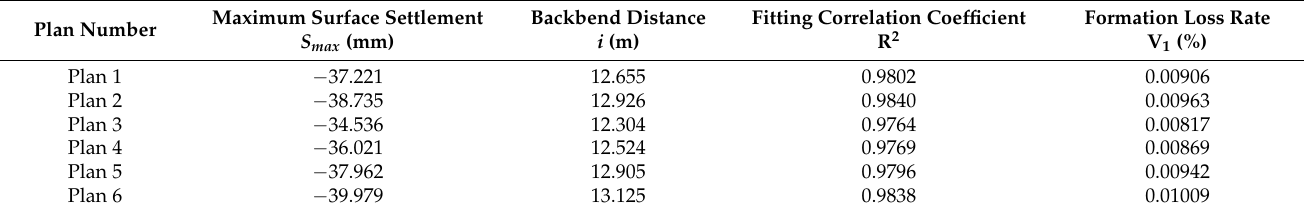
Table 5. Summary of fitting results.